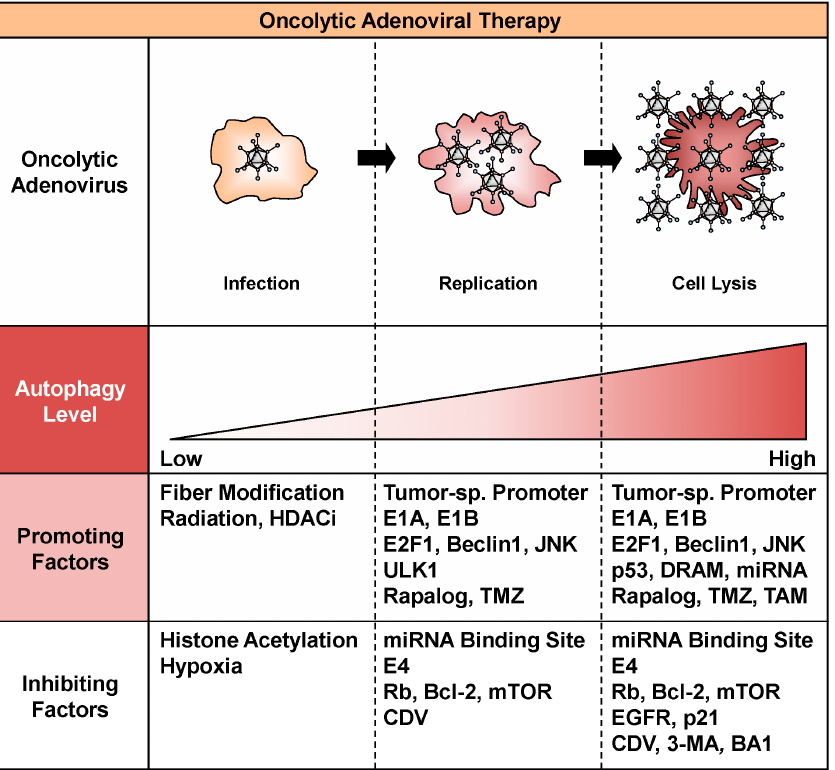
Figure 2. Factors that promote or inhibit oncolytic adenovirus-mediated autophagy. Factors that promote or inhibit oncolytic adenovirus-mediated autophagy are shown. HDACi, histone deacetylase inhibitor; JNK, c-Jun N-terminal kinase; ULK1, unc-51-like autophagy-activating kinase 1; TMZ, temzolomide; miRNA, microRNA; mTOR, mammalian target of rapamycin; CDV, cidofovir; DRAM, damage-regulated autophagy modulator; TAM, tamoxifen; EGFR, epidermal growth factor receptor; 3-MA, 3-methyladenine; BA1, bafilomycin A1. receptor; 3-MA, 3-methyladenine; BA1, bafilomycin